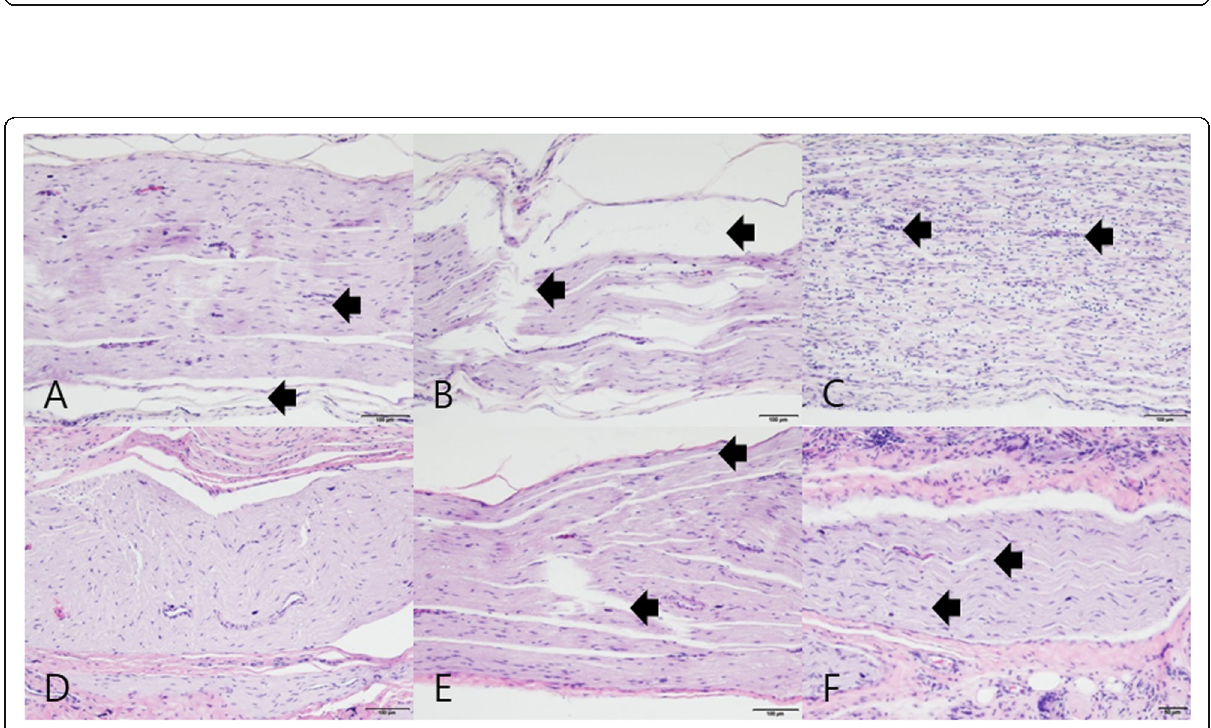
Fig. 8 Cross-sectional image of the sciatic nerve. A Group A at 2 weeks: homogenous thickness and distribution of nerve fibers. B Group B at 2 weeks: dead spaces between fibers (arrow). C Group C at 2 weeks: separations between fibers (arrow). D Group A at 4 weeks: no significant difference with the result obtained at 2 weeks. E Group B at 4 weeks: dead spaces between fibers (arrow). F Group C at 4 weeks: decreased separations between fibers, with relatively homogeneous density compared with the result at 2 weeks after surgery (arrow). (Hematoxylin and eosin staining, ×40 magnification)